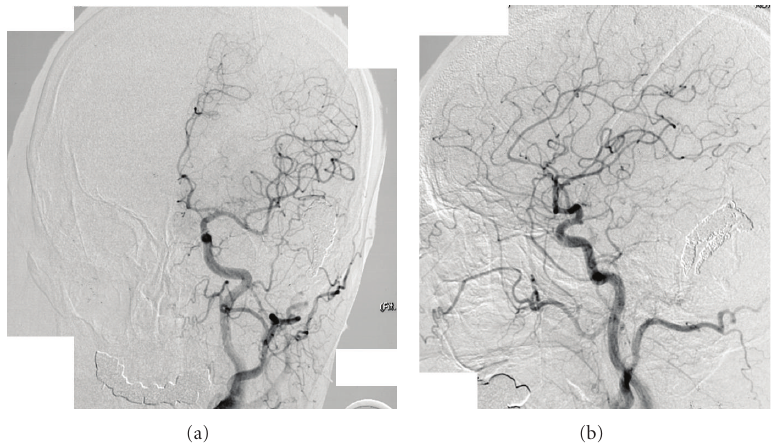
Figure 3: A DAVF disappeared on the angiograms (a) anteroposterior view and (b) lateral view [2,